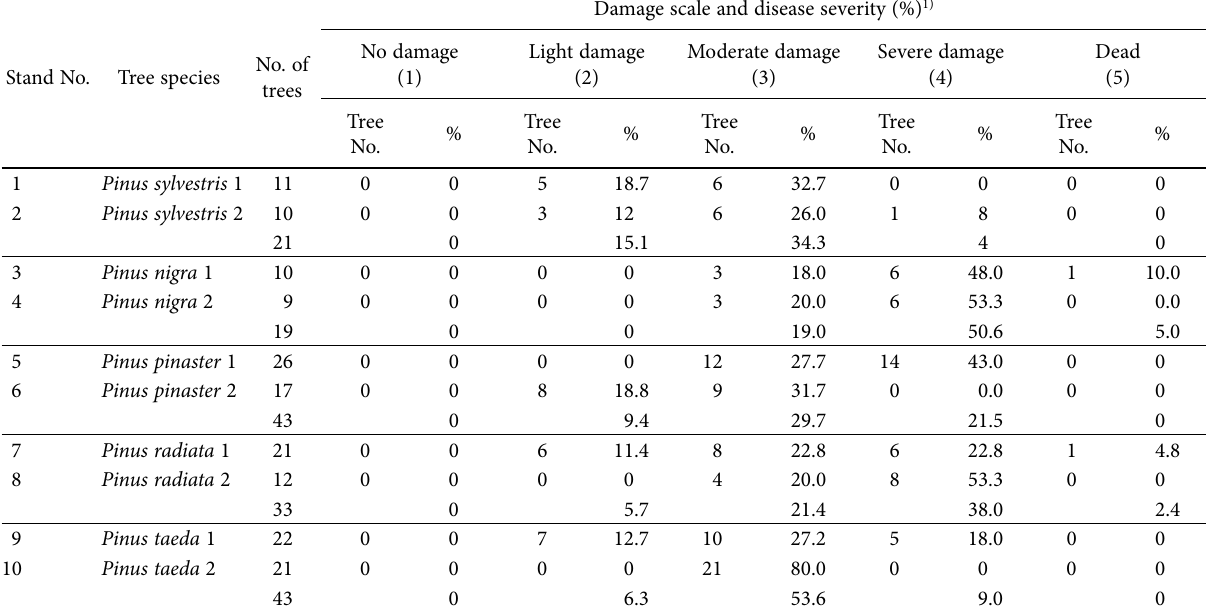
Table 3. Diplodia shoot dieback severity assessments.